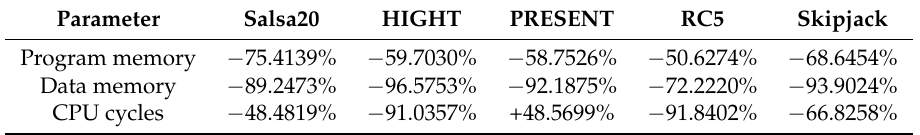
Table 11. Difference in the percentage of computing resource utilization of the algorithms against GBPA. Parameter Salsa20 HIGHT PRESENT RC5 Skipjack Program memory − 75.4139% − 59.7030% − 58.7526% − 50.6274% − 68.6454% Data memory − 89.2473% − 96.5753% − 92.1875% − 72.2220% − 93.9024% CPU cycles − 48.4819% − 91.0357% +48.5699% − 91.8402% −